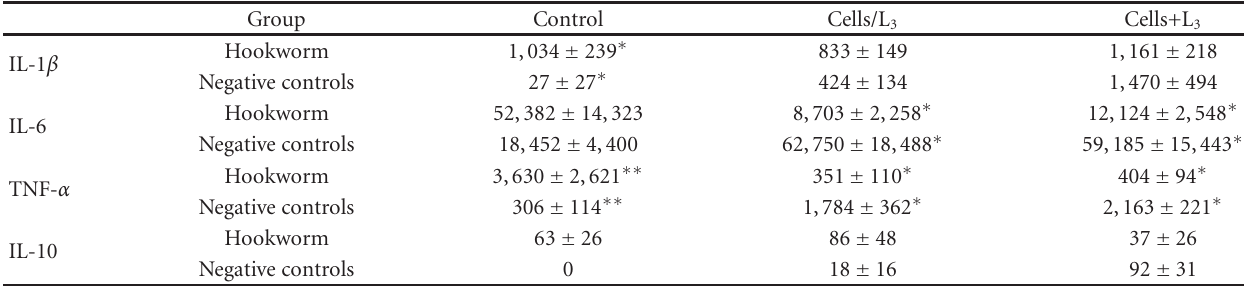
Table 2: Cytokine concentrations (pg/mL) in supernatants of PBMC cultures cocultured with living L 3 from Ancylostoma caninum . Cells were either separated from the L 3 by a membrane insert (cells/L 3 ) or were cultivated in direct contact with the parasites (cells+L 3 ). Values from hookworm-infected individuals ( n = 7) and negative controls ( n = 6) are compared and indicated as mean values ± standard errors. Significant di ff erences between patient groups are indicated with an asterisk ( ∗ P < . 01; ∗∗ P < .